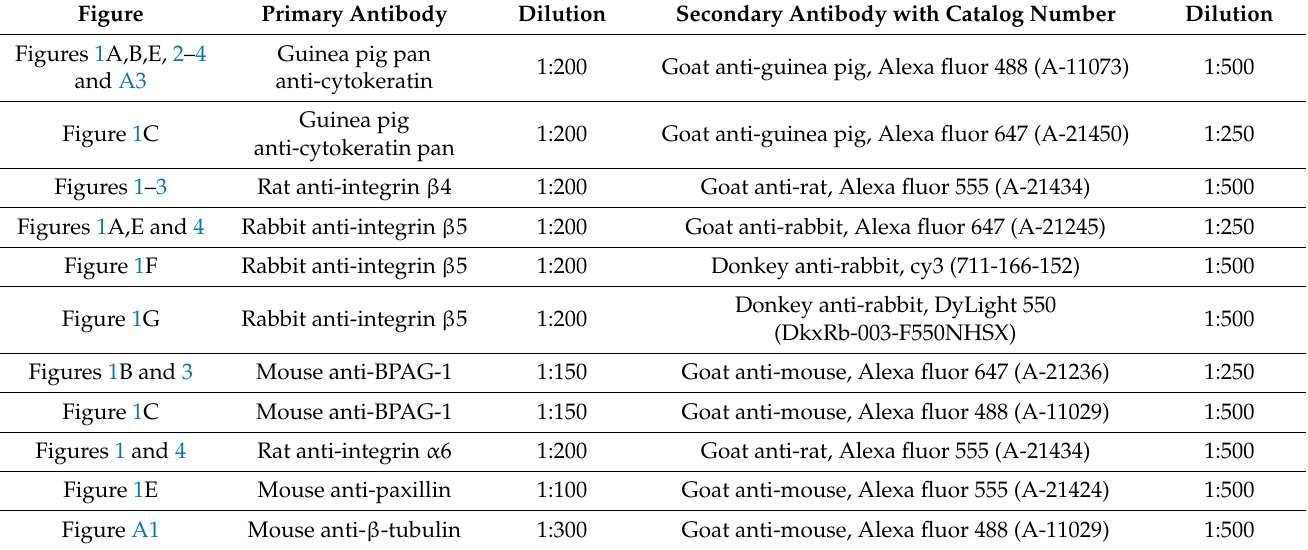
Table A1. List of primary and secondary antibody combinations and concentrations. Figure